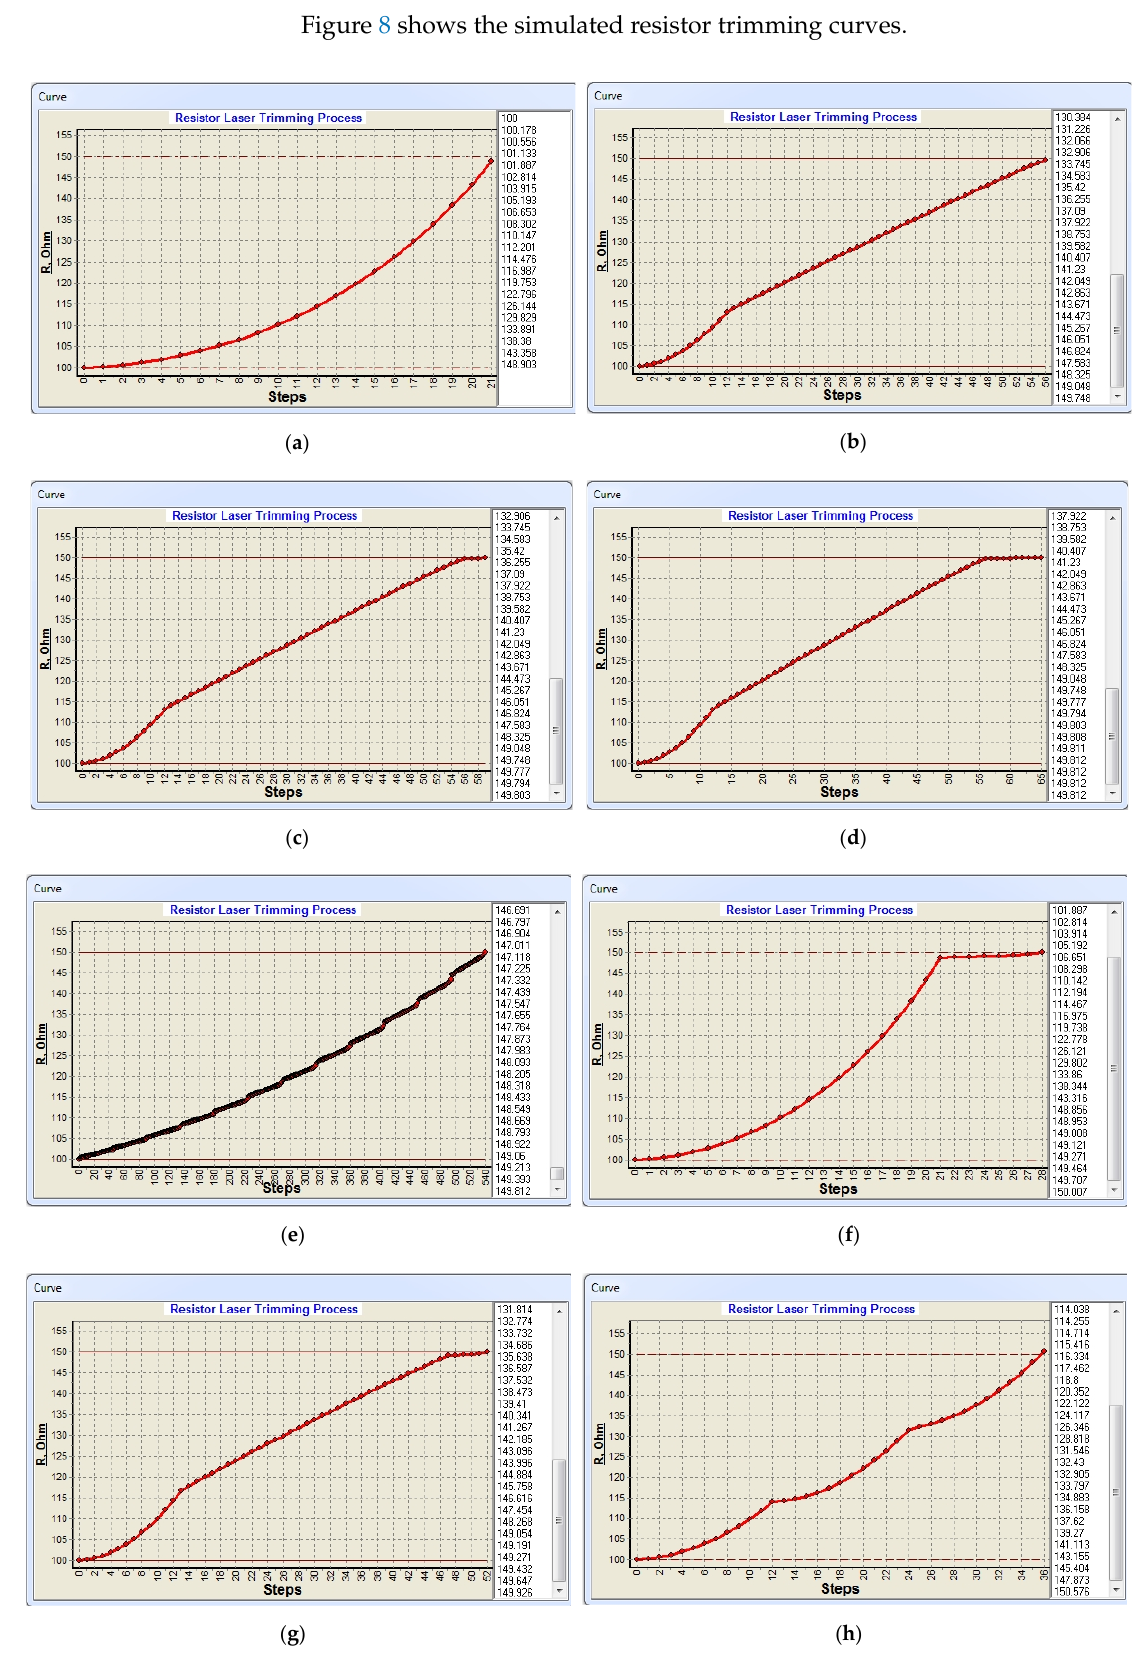
Figure 8. Resistor trimming curves for the trim types studied. The figure shows the RTCs for the following trim types: ( a ) I ‐ cut; ( b ) L ‐ cut; ( c ) J ‐ cut; ( d ) U ‐ cut; ( e ) S ‐ cut; ( f ) Ii ‐ cut; ( g ) Li ‐ cut; ( h ) W ‐ cut. The RTCs are resistance vs. laser trim length curves. The path length is measured in steps. One step is the size of a